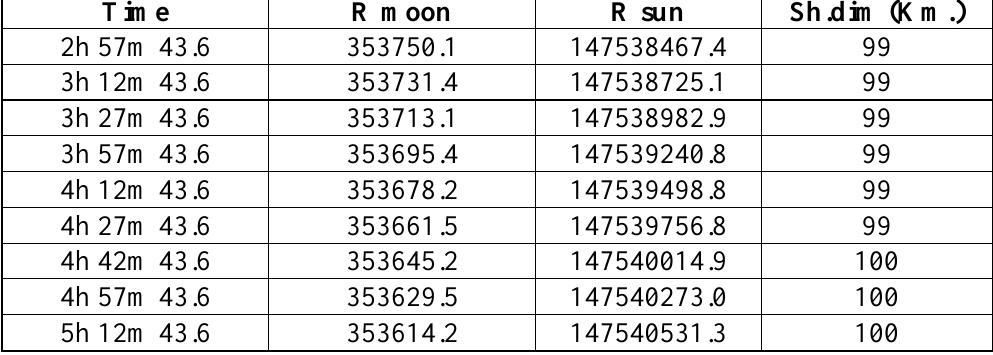
Table (11-a): YY = .305644197 CENTRAL ECLPSE